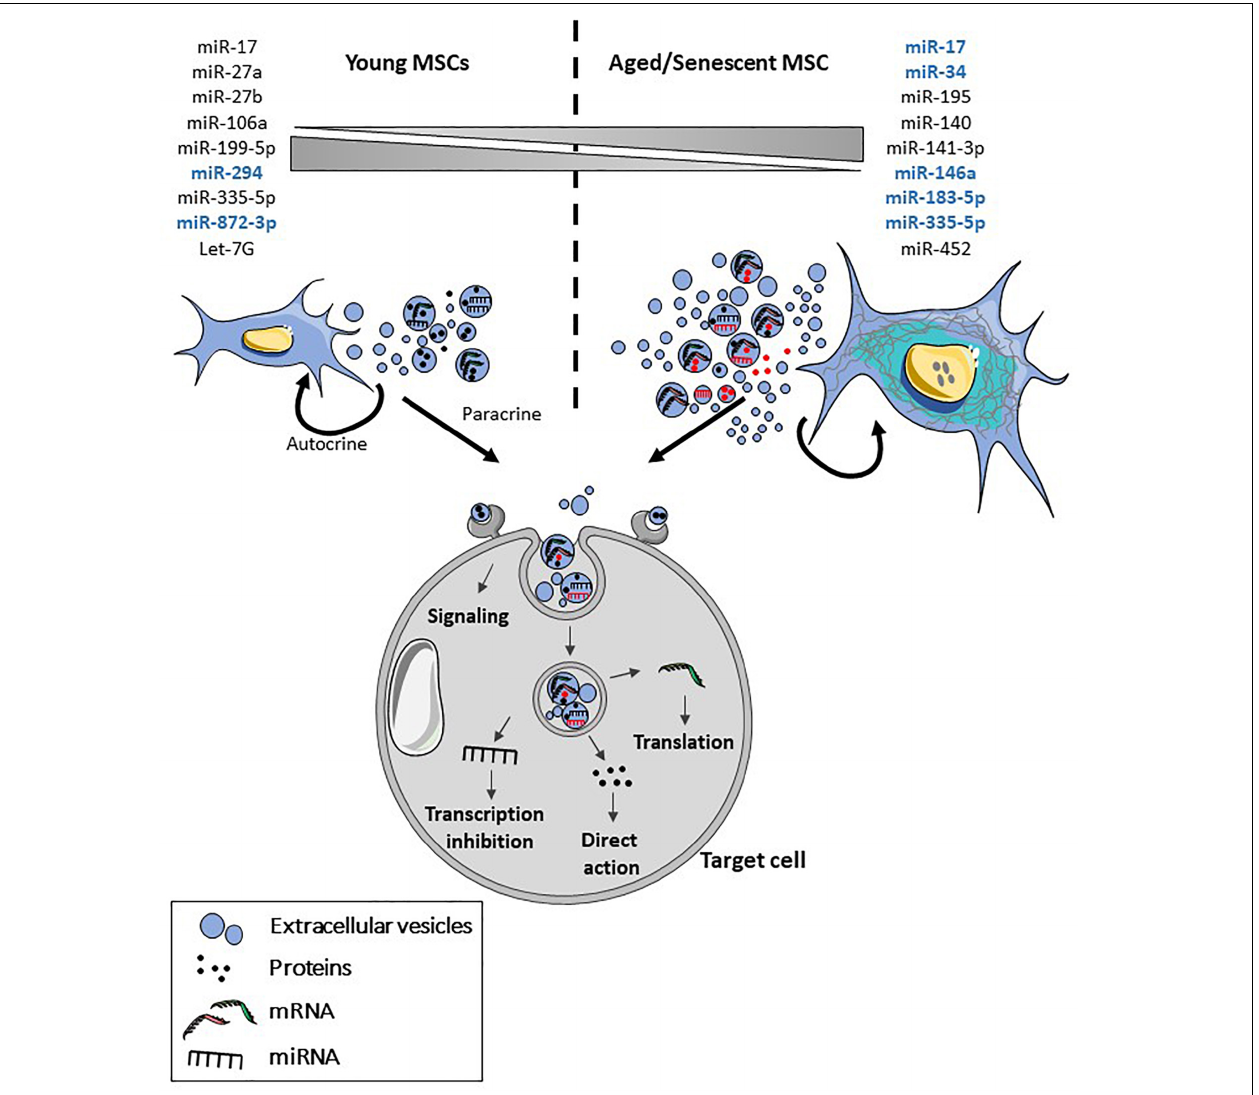
FIGURE 2 | Features of senescent MSC-EVs. With aging and senescence, production of EVs by MSCs is increased and their cargo is altered. Both the content in different types of molecules and their number may be altered in MSCs. More specifically, several miRNAs have been identified as being modulated in MSCs and in MSC-EVs (blue) with aging and/or senescence. Upon release, MSC-EVs will interact in an autocrine and paracrine manner with the parental and target cells contributing to senescence propagation. Senescent MSC-EVs can interact directly with cell surface receptors and induce intracellular signaling pathways or fuse with the plasma membrane or be internalized by endocytosis. After internalization, proteins, miRNA and mRNA are released in the cytosol where they are functionally